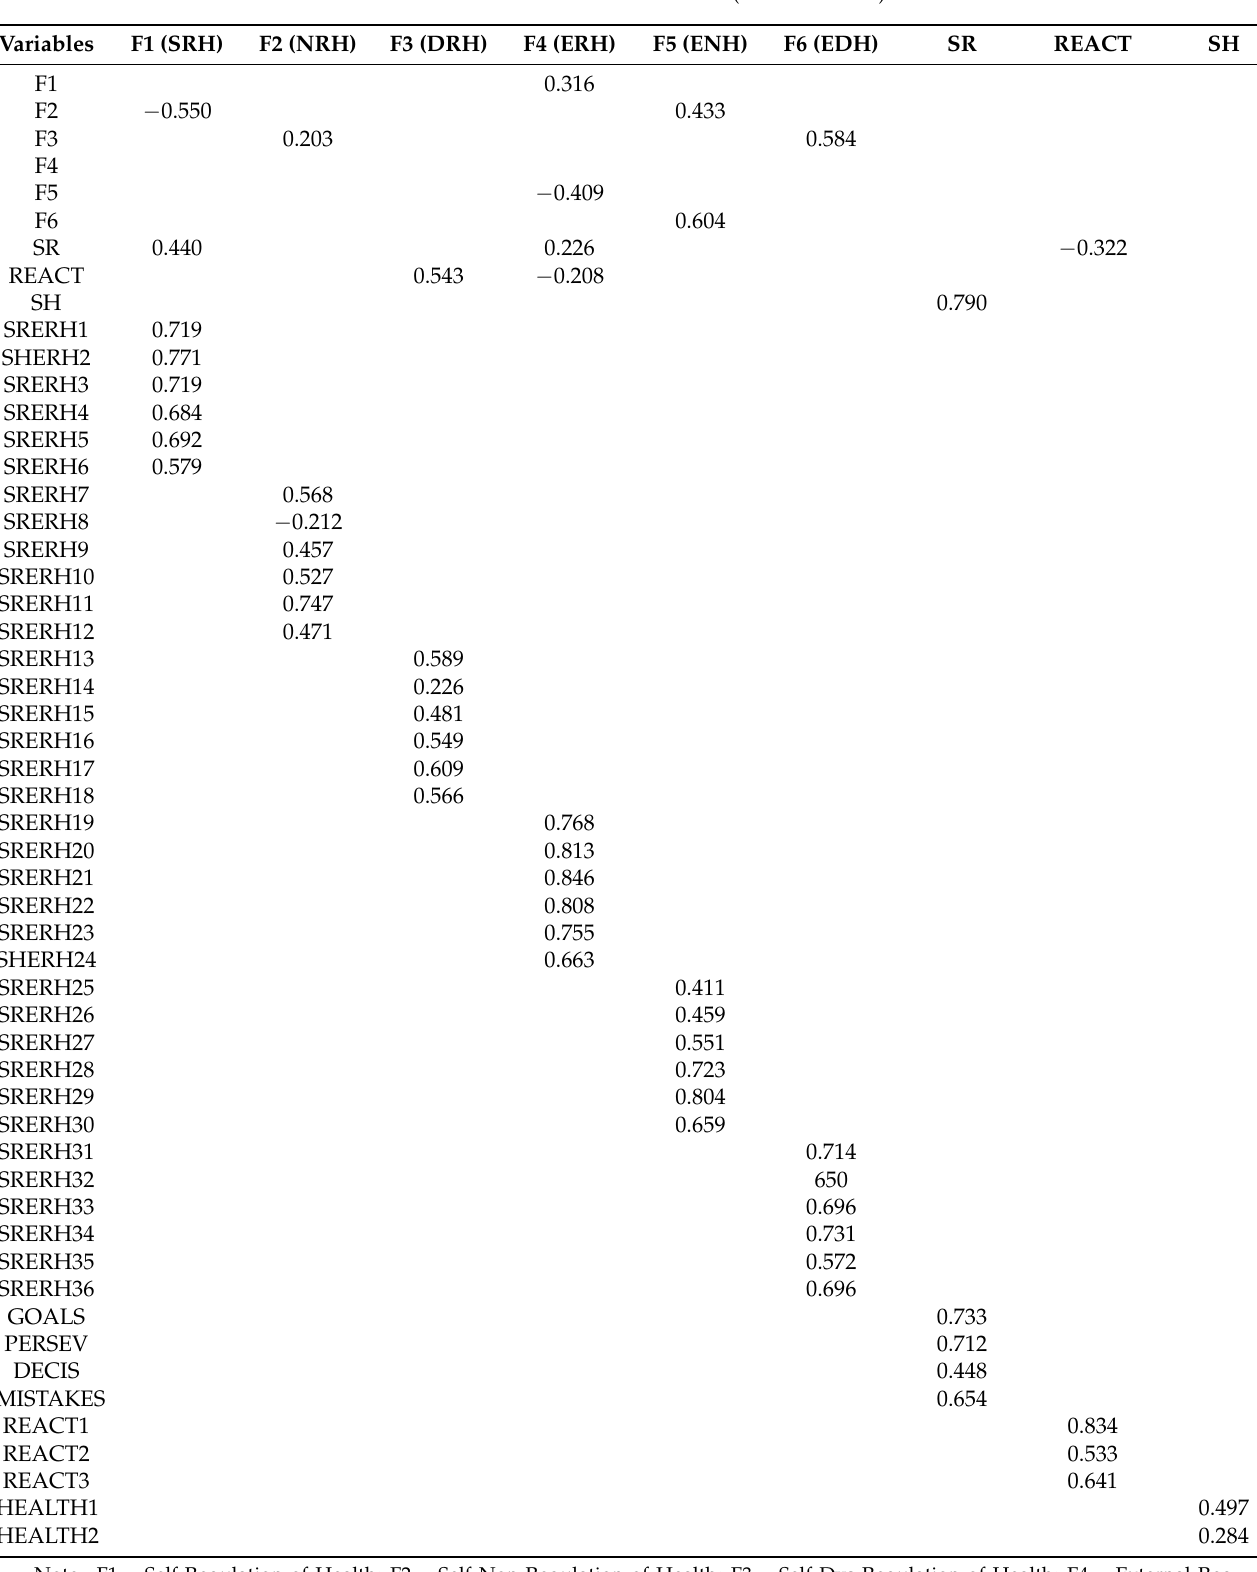
Table 8. Standardized direct effects (default